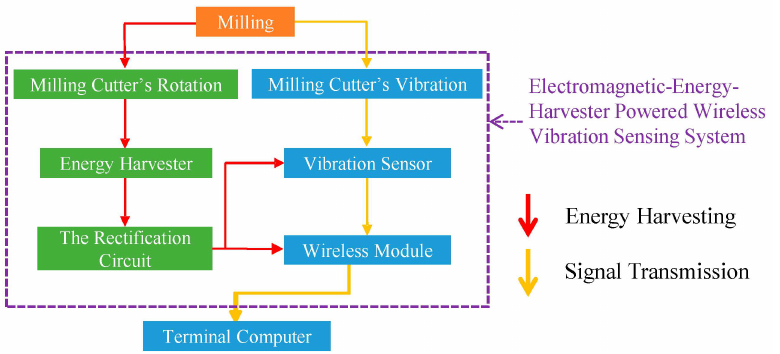
Figure 1. The energy harvesting and vibration-signal transmission approaches of the attachable electromagnetic energy harvester driven wireless vibration sensing system to monitor milling-processes and cutter-wear/breakage conditions. The red arrow-line indicates the energy-harvesting flow while the yellow arrow-line indicates the signal-transmission